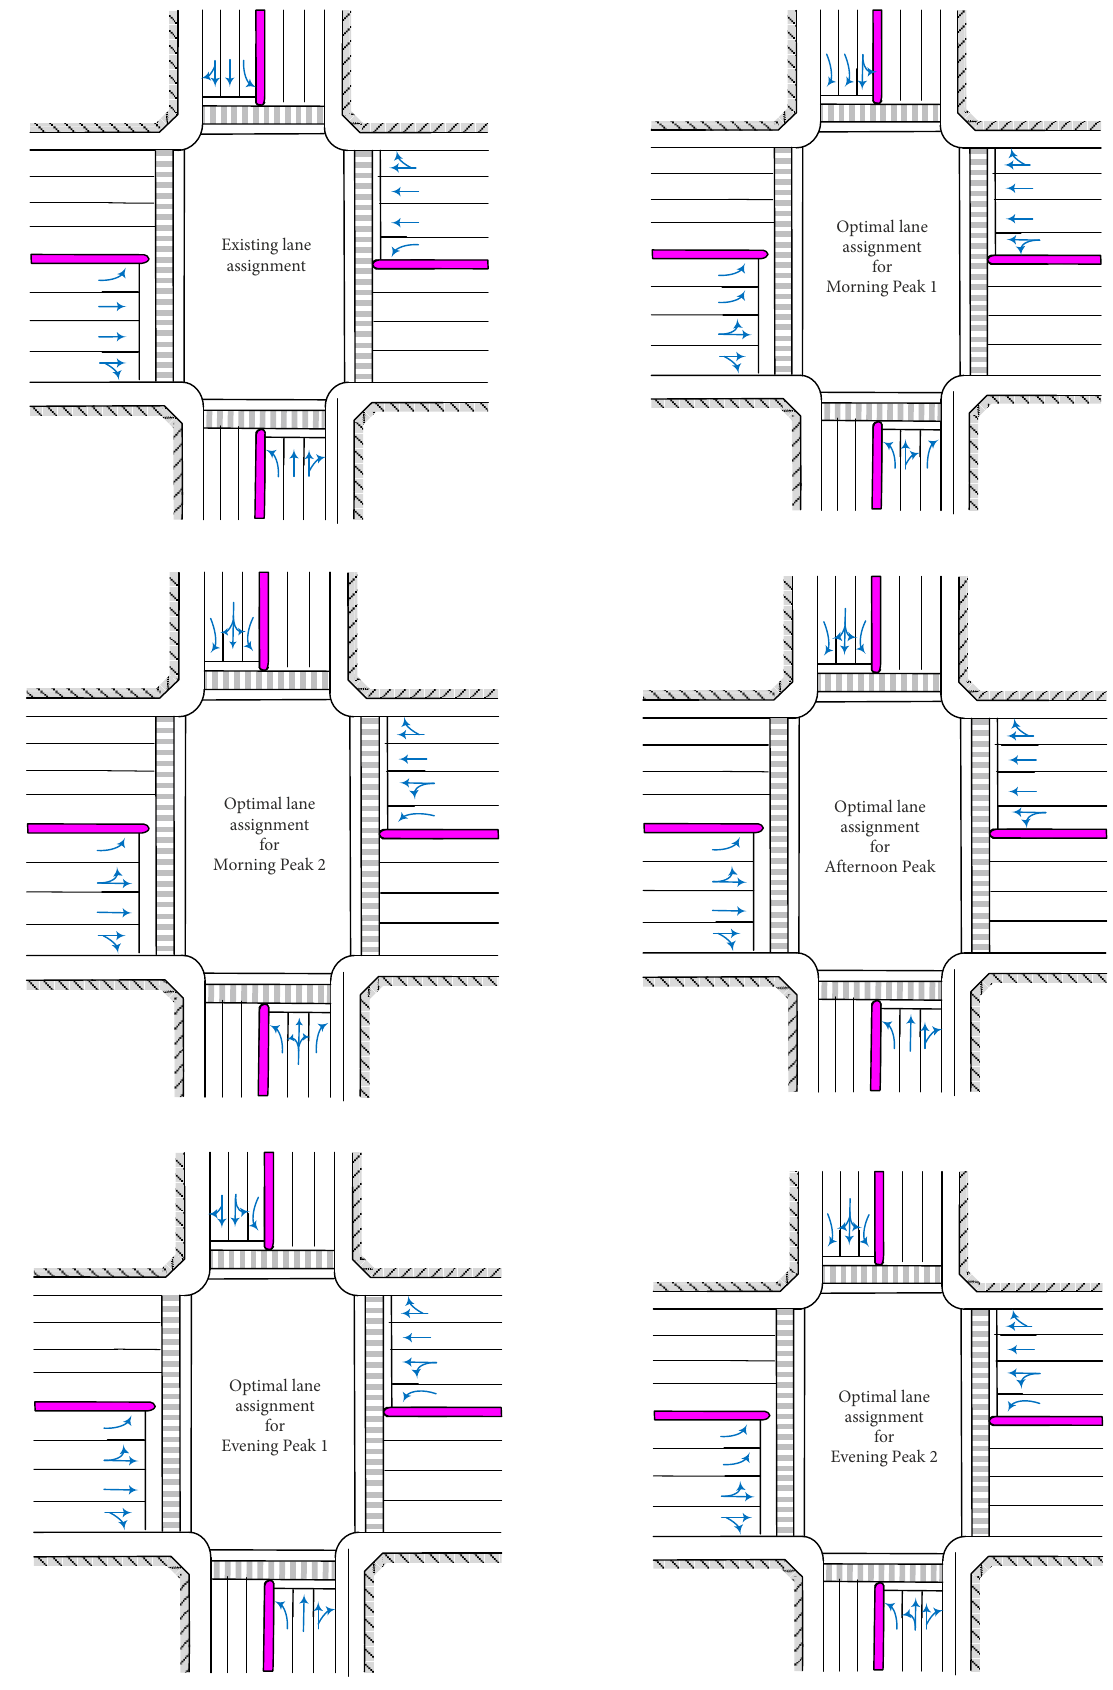
Figure 6. Existing and optimal lane assignment for the studied intersection in each peak